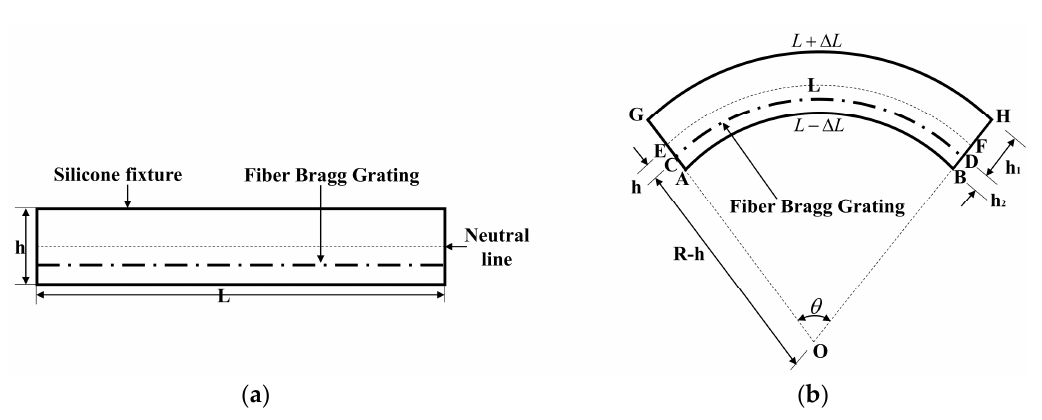
Figure 5. Bending mechanism of the FBG-based optical fiber sensor. ( a ) Free-state without bending. ( b ) Bending situation.